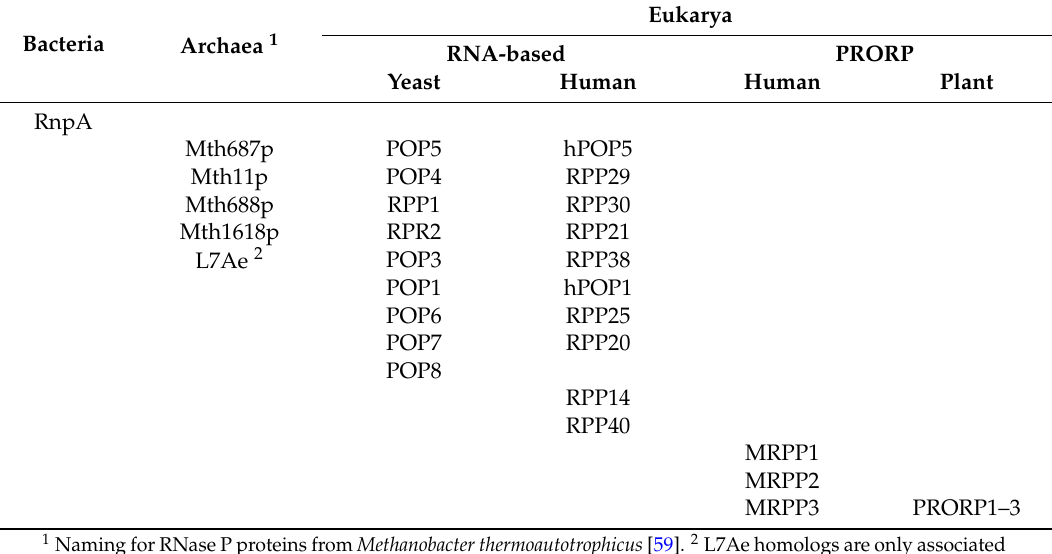
Table 1. Conservation of RNase P protein components across the domains of life. RnpA proteins from various Bacteria share homology to each other, but not to archaeal or eukaryotic proteins. Archaeal and eukaryotic nuclear RNase P proteins share sequence homology with proteins on the same row. Protein-only RNase P components do not share homology with any of the RNA-based RNase P protein